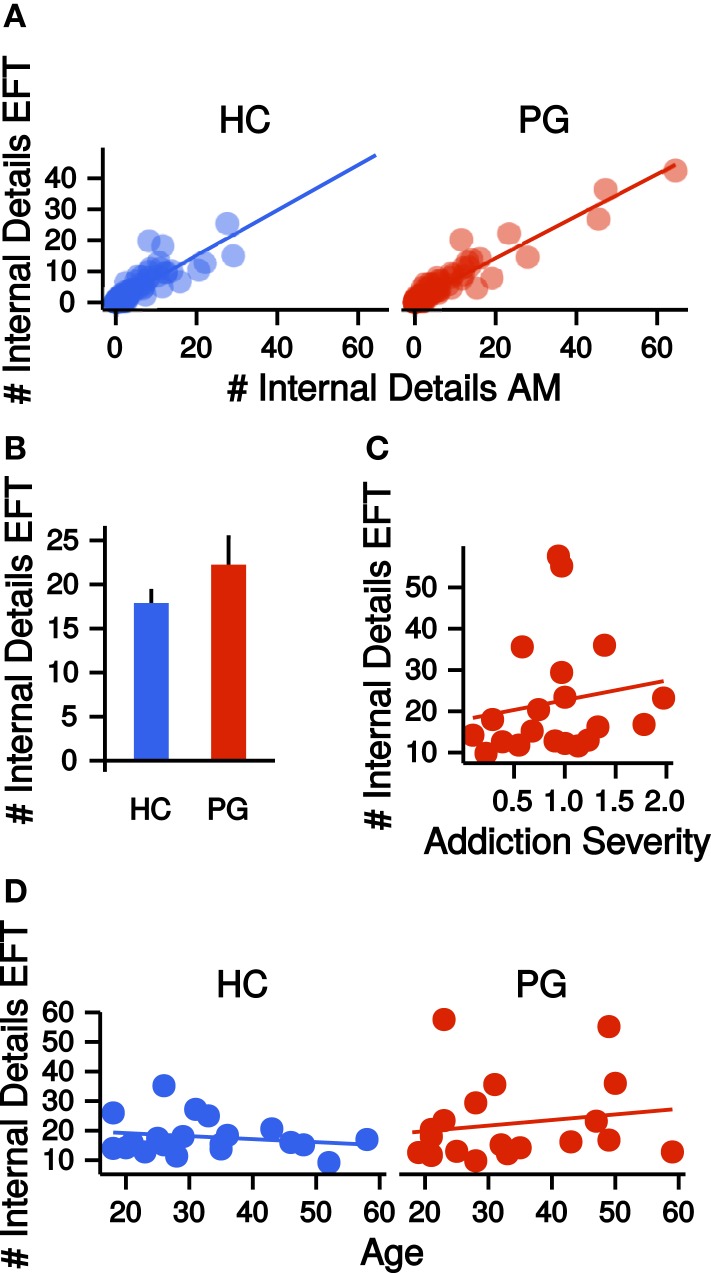
(A) Correlations of the number of internal details reported in the autobiographical memory (AM) condition with the number of internal details reported in the episodic future thinking (EFT) condition, separate for healthy control participants (HCs, r = 0.86, p < 0.001) and pathological gamblers (PGs, r = 0.95, p < 0.001). (B) Group difference in the number of internal details in the EFT condition. HC: healthy control participants, PG: pathological gamblers. Error bars are indicating SEM. (C) Correlation of number of internal details in the EFT condition with addiction severity scores in PGs (r = 0.16, p = 0.48). (D) Correlation of number of internal details in the EFT condition with age separate for HCs (r = −0.19, p = 0.42) and PGs (r = 0.16, p = 0.48).